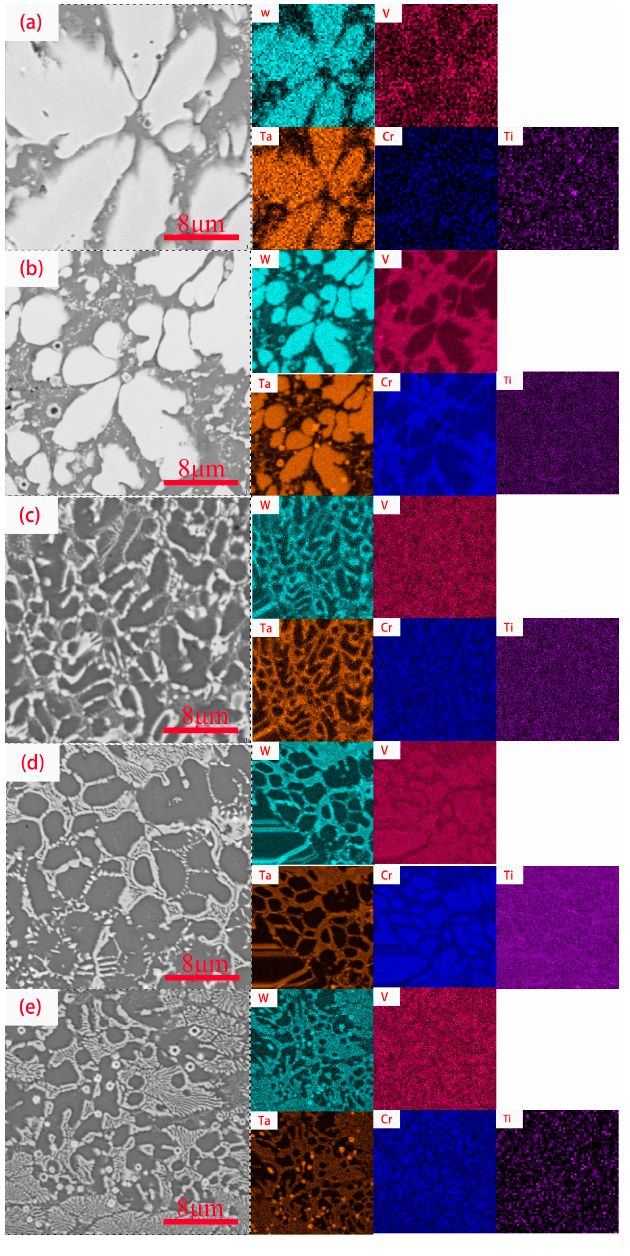
Figure 3. EDS of cross section of WVTaTiCr x RHEA coating: ( a ) Cr 0 ; ( b ) Cr 0.25 ; ( c ) Cr 0.5 ; ( d ) Cr 0.75 ; ( e ) Cr 1 .